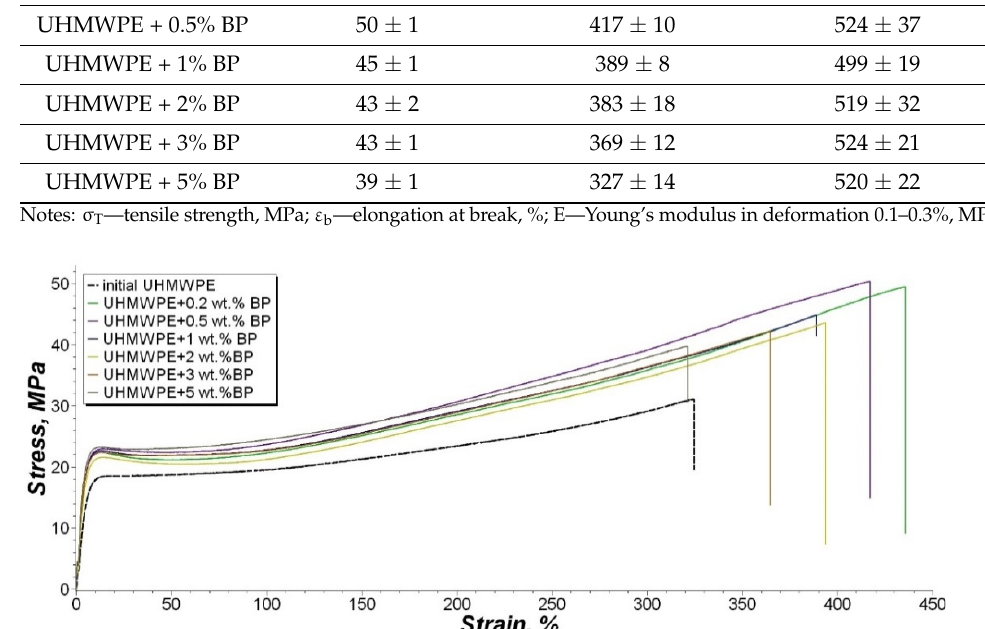
Table 3. Elongation at break, tensile strength, and Young’s modulus of UHMWPE and PCM with borpolymer (BP).